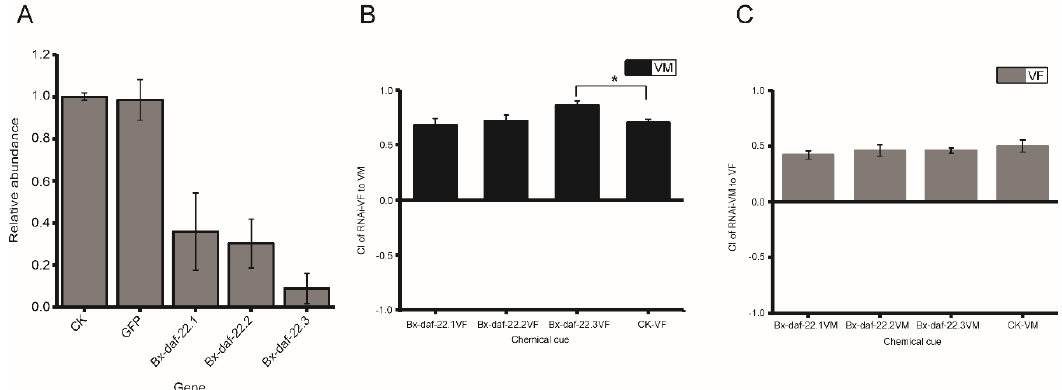
Figure 6. Expression levels of the Bx-daf-22 genes and effects of male and female secretions on the opposite sex after RNAi of three Bx-daf-22 genes individually. ( A ) Transcript abundance of Bx-daf-22 genes after nematodes treated with dsRNA of individual gene for 36 h. ( B ) Attractiveness of secretions from RNAi-treated females on males. ( C ) Attractiveness of secretions from RNAi-treated males on females. CK: the positive control, nematodes treated with the M9 buffer alone. GFP: the negative control, nematodes treated with dsRNA of gfp . Bx-daf-22.1 : nematodes treated with dsRNA of Bx-daf-22.1 . Bx-daf-22.2 : nematodes treated with dsRNA of Bx-daf-22.2 . Bx-daf-22.3 : nematodes treated with dsRNA of Bx-daf-22.3 . Bx-daf-22.1 -VF/VM: virgin female/male treated with dsRNA of Bx-daf-22 .1. Bx-daf-22.2 -VF/VM: virgin female/male treated with dsRNA of Bx-daf-22 .2. Bx-daf-22.3 -F/M: virgin female/male treated with dsRNA of Bx-daf-22 .3. CK-VF/CK-VM: virgin female/male treated with M9 alone. CK-CK: the negative control, chemotaxis assay use ddH 2 O on the two spots. CI (chemotaxis index) = ((number of nematodes at the test zone) − (number of nematodes at the control zone))/total number of nematodes. VF: virgin female VM: virgin male. * p < 0.05.